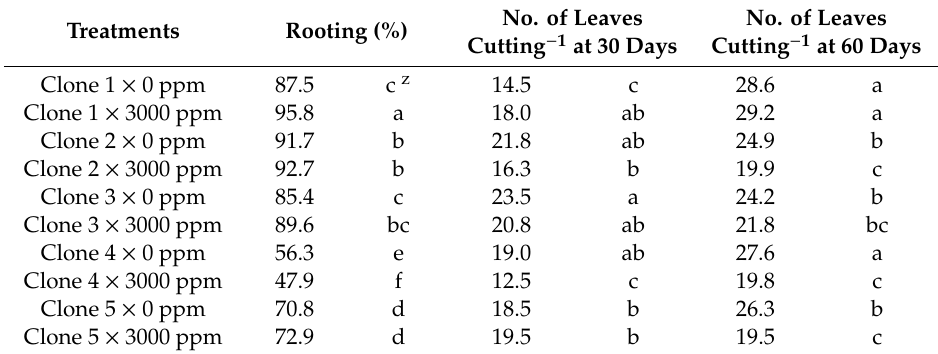
No. of Leaves No. of Leaves Cutting − 1 at 30 Days Cutting − 1 at 60 Days